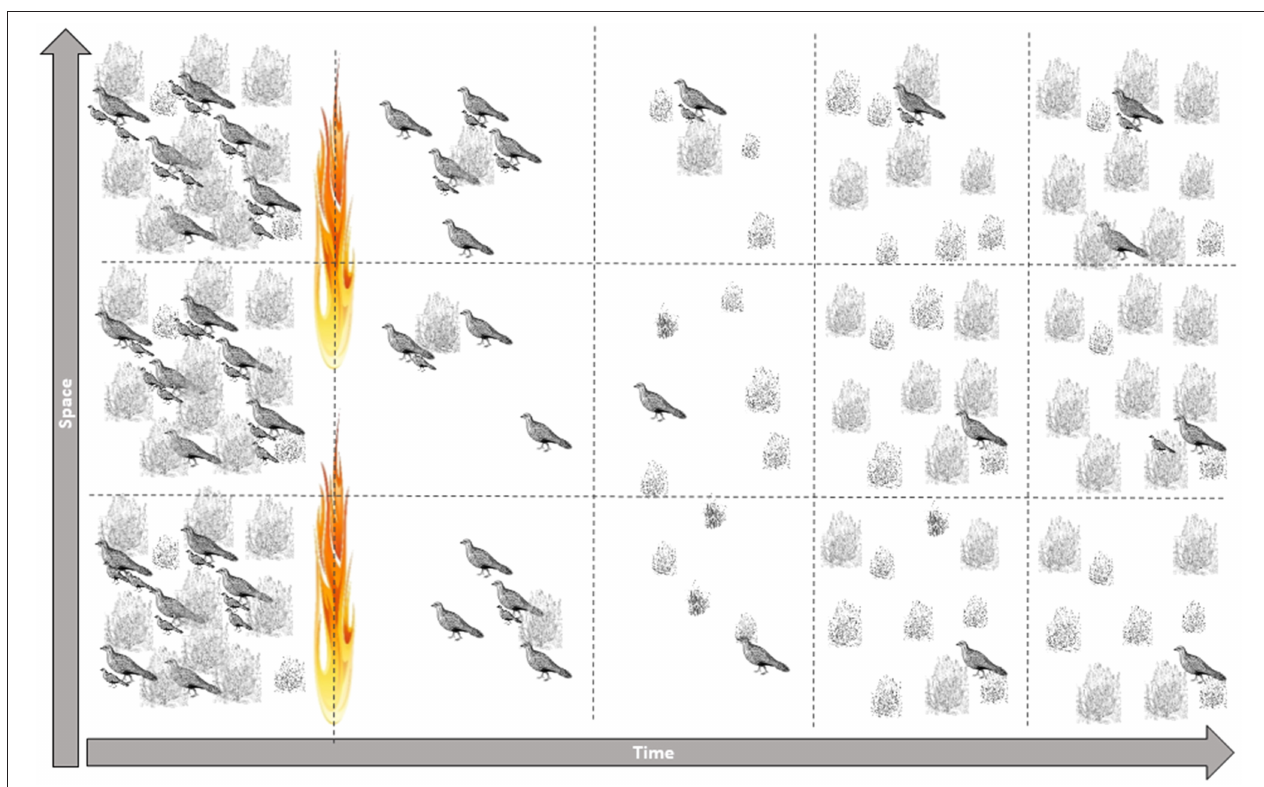
FIGURE 1 | Simple conceptual model illustrating asynchronies in engineering resilience between sage-grouse and sagebrush populations post-disturbance (e.g., wildfire). Even if sagebrush engineering resilience is high (as in high RandR habitats), sage-grouse population performance has lagged severely by the time sagebrush reaches pre-disturbance conditions. Reductions in survival and recruitment are illustrated by fewer hens with chicks; dashed lines represent time intervals; dashed horizontal lines represent closed populations. Spatial resilience is compromised when disturbance becomes widespread going from bottom to